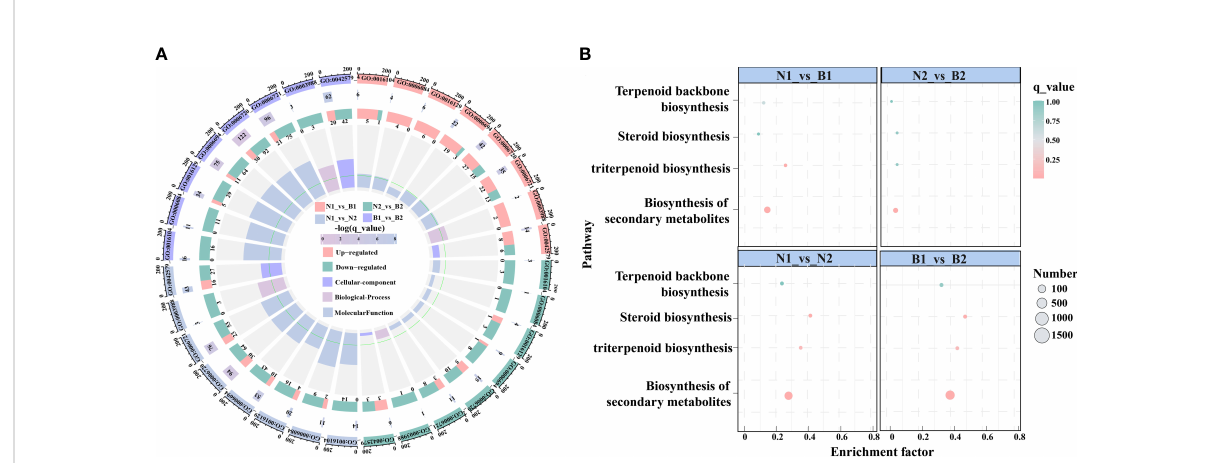
FIGURE 2 Enrichment analyses of the differentially expressed genes (DEGs) related to triterpenoid saponin (TS) biosynthesis. (A) shows Gene Ontology (GO) enrichment analyses of DEGs among the above four comparison groups. It is composed of four cycles. Cycle 1 (Cy1, the outermost cycle) means nine GO terms located in the above four comparison groups. Cycle 2 (Cy2, the secondary outer cycle) means the number of DEGs corresponding to GO terms. The different colors of the rectangles below the number are the q_value (-log10). Cycle 3 (Cy3, the sub-internal cycle) means the number of upregulated and downregulated genes corresponding to GO Classify2, which were labeled in pink and green, respectively. Cycle 4 (Cy4, the innermost cycle) means the enrichment range and the enrichment factors of GO terms, including cellular components, biological processes, and molecular functions. The green circular line indicates enrichment factor = 1. (B) shows the Kyoto Encyclopedia of Genes and Genomes (KEGG) pathway enrichment analyses of DEGs in N1_ vs _B1, N2_ vs _B2, N1_ vs _N2, and B1_ vs _B2 comparison groups. The abscissa and ordinate denote the enrichment factors and pathways, respectively. The size and color of the circles represent the number and q_value of